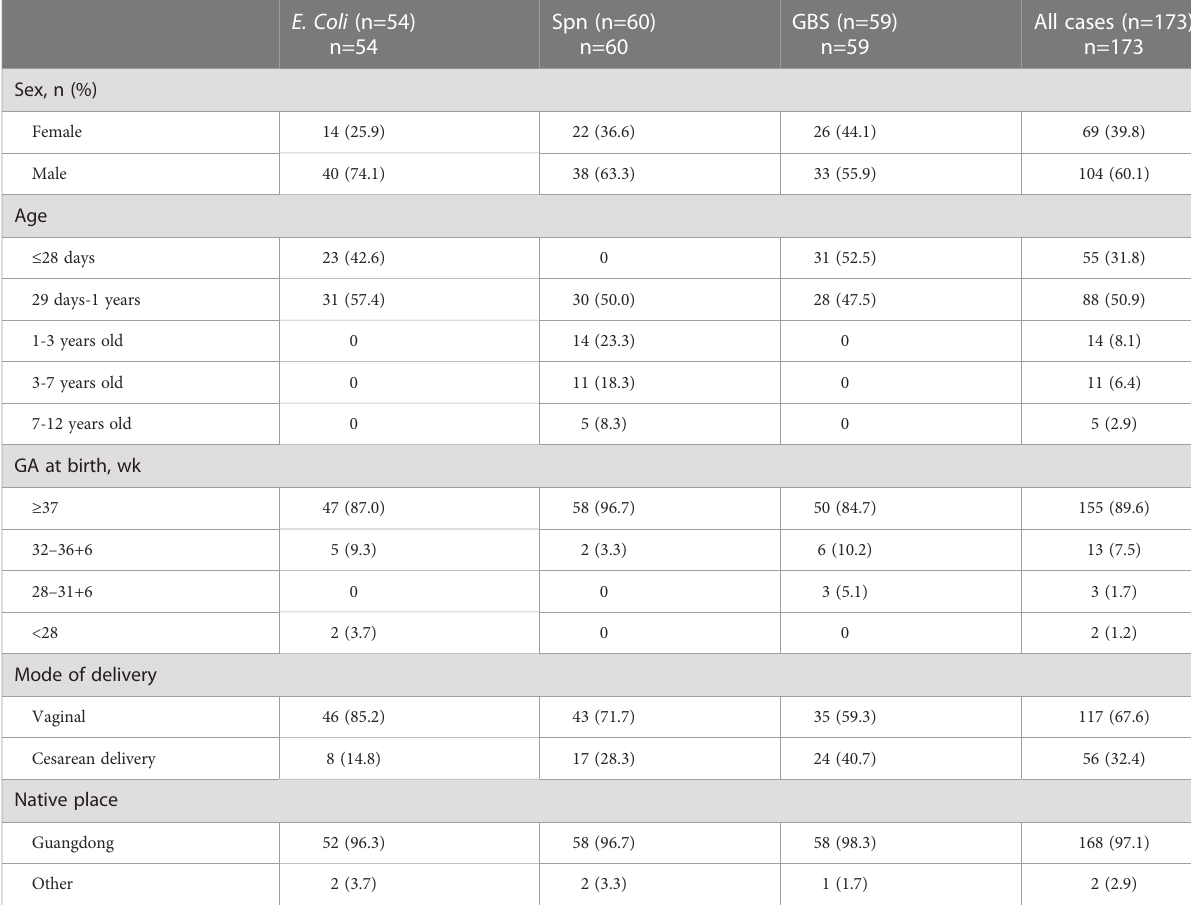
TABLE 1 Comparison of patient characteristics diagnosed with different etiologies of bacterial